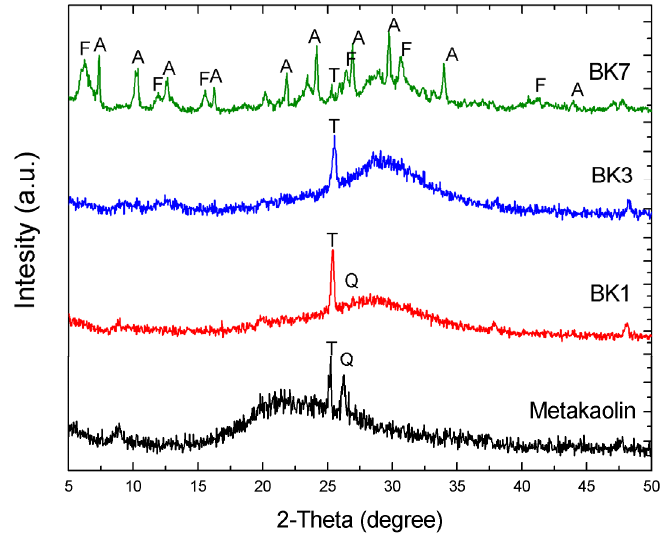
Figure 1. XRD pattern of metakaolin, BK1, BK3, and BK7. T: anatase TiO 2 ; A: Linde type A zeolite; F: Faujasite.